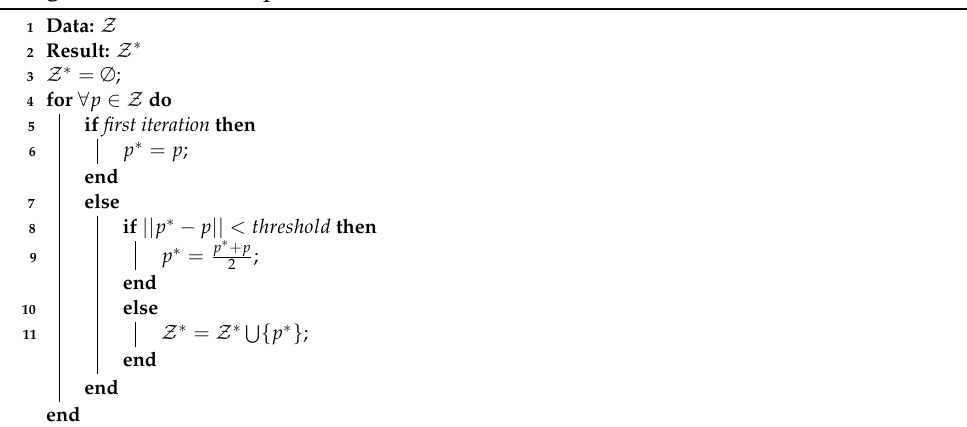
Algorithm 2: The computation of Z ∗ .